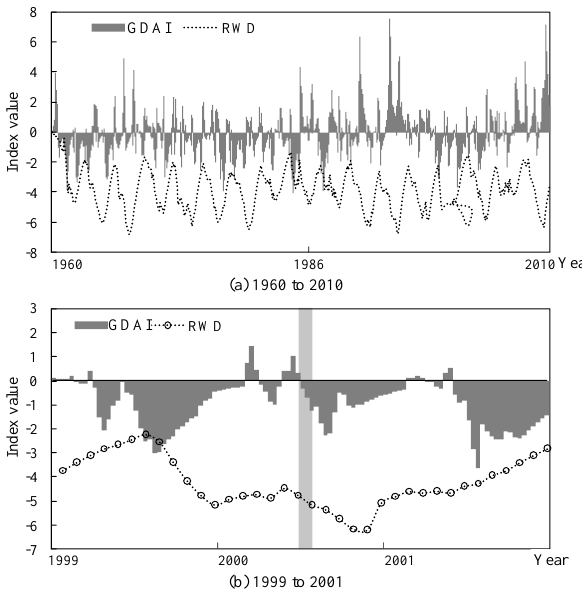
Figure 16. Compared the GDAI with the RWD in Gongzhuling